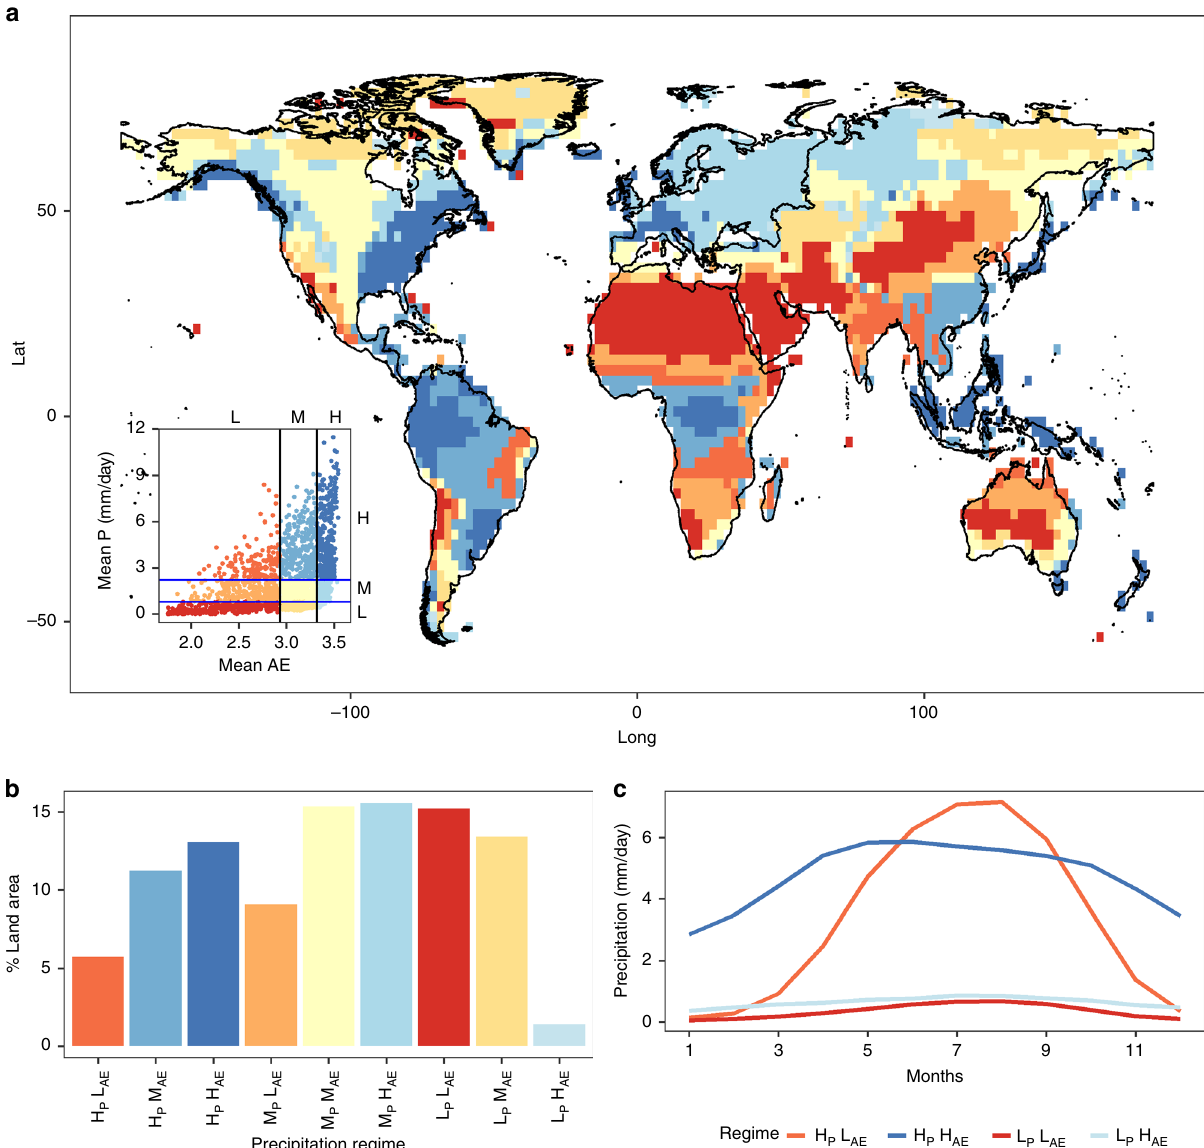
Fig. 1 Classi fi cation of the precipitation regimes. a Spatial distribution of precipitation regimes based on the percentile (Pr i ) thresholds concept using mean apportionment entropy (AE) and annual precipitation P during the 1971 – 2000 reference period. b Percentage of land occupied by each regime. c Precipitation climatology of the spatially aggregated monthly rainfall climatology for regimes H P L AE , H P H AE , L P H AE , L P L AE . These regimes are selected as they represent boundary case scenarios. H, M, and L represent high moderate and low values,